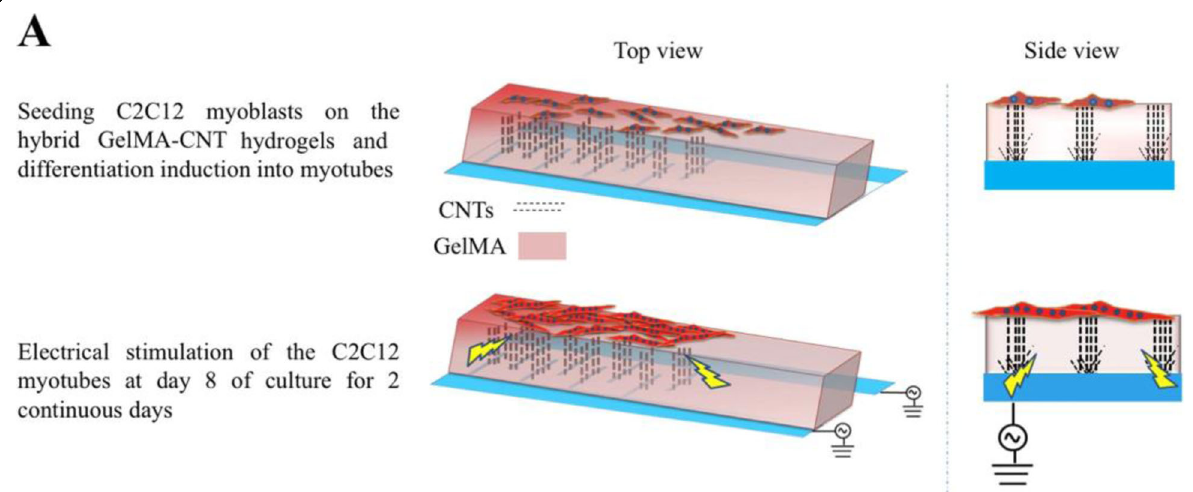
Fig. 7 a Schematic representation of C2C12 myoblasts were randomly cultured on hybrid GelMA-vertically aligned CNT. Reproduced with permission [109]. Copyright (2014), Springer